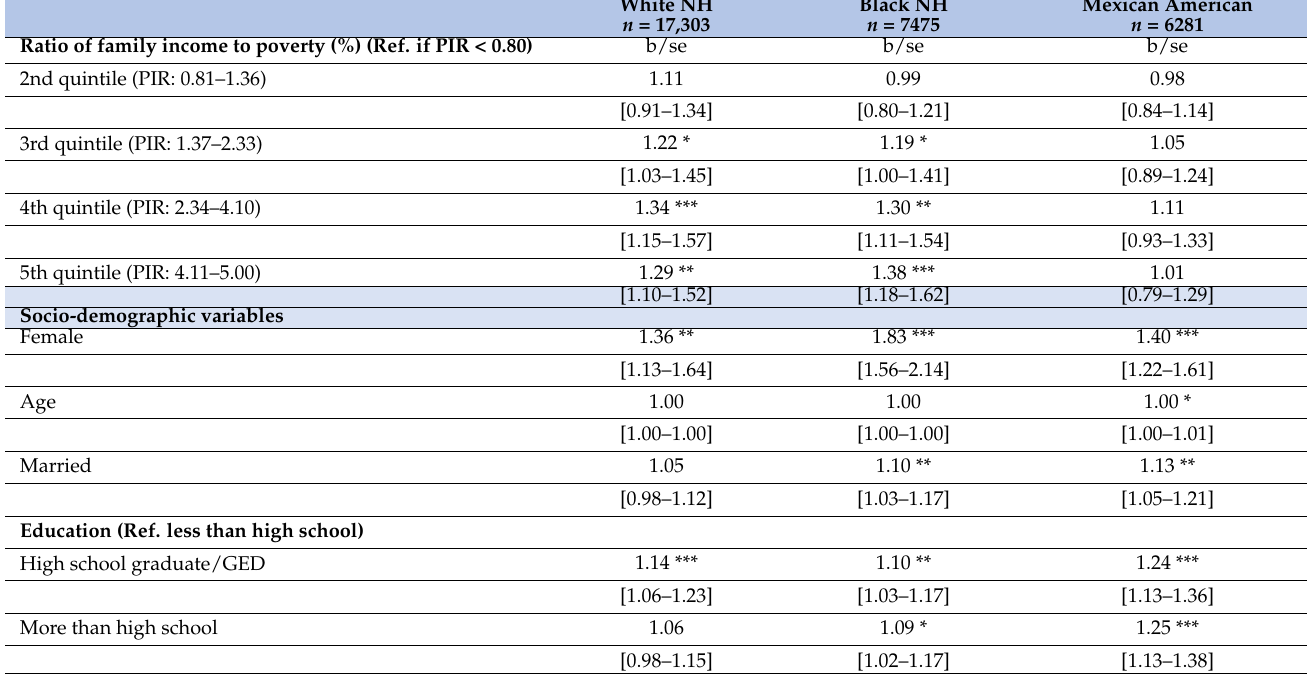
Table 3. Association between PIR and obesity across racial/ethnic groups in U.S. adults, 1999–2016.